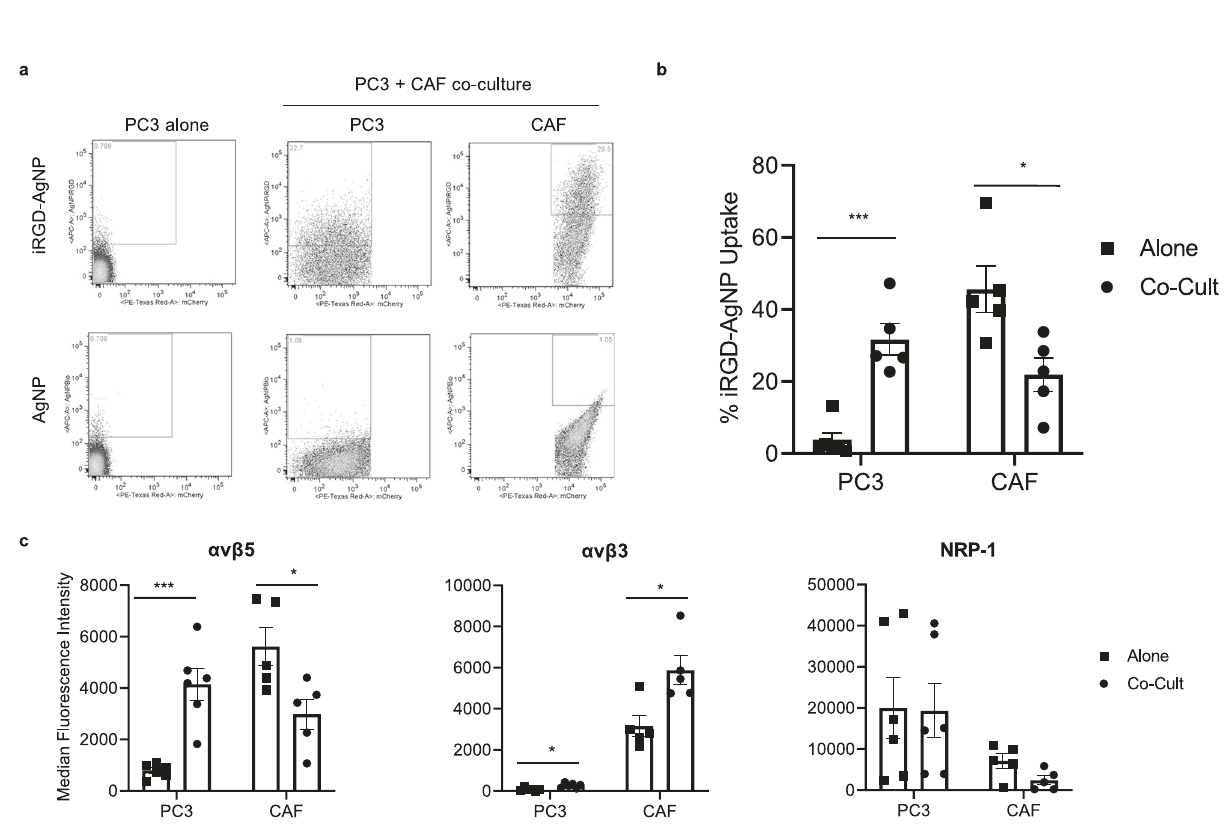
Fig. 3 CAFs enhance iRGD entry into tumor cells. a Flow cytometry analysis showing entry of iRGD-AgNP or control AgNP into spheroids made of PC3 tumor cells alone or PC3 cells mixed with mCherry-labeled hPCF1424 CAFs (co-cult). Note that iRGD-AgNPs entered PC3 cells more ef fi ciently in the presence of CAFs. b Quanti fi ed results of ( a ). Proportion of cells that internalized the particles are shown. n = 5 independent experiments. Two-tailed unpaired t test; p = 0.00015 (PC3 alone vs co-cult), p = 0.0177 (CAF alone vs. co-cult). c Flow cytometry analysis showing the expression of α v β 5 and α v β 3 integrins and NRP-1 in PC3 and CAF spheroids cultured alone (gray bars) or co-cultured with each other (black bars). n = 6 independent experiments. Two-tailed unpaired Student ’ s t test; p = 0.000325 ( α v β 5: PC3 alone vs. co-cult), p = 0.0247 ( α v β 5: CAF alone vs. co-cult), p = 0.0158 ( α v β 3: PC3 alone vs. co-cult), p = 0.0132 ( α v β 3: CAF alone vs. co-cult), p = 0.947 (NRP-1: PC3 alone vs. co-cult), p = 0.055 (CAF alone vs. co-cult). All error bars, SEM. * p < 0.05; *** p < 0.001. Source data provided in Source Data fi